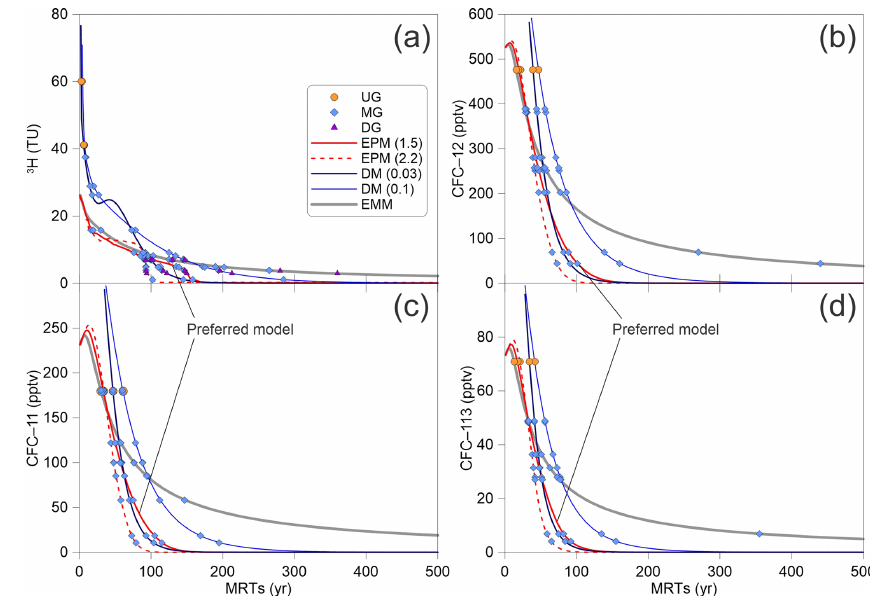
Figure 10. Tritium and CFCs (CFC-11, CFC-12, and CFC-113) output vs. mean residence times for different lumped parameter models estimated using Eqs. (2) to (5). The input 3 H activity and CFCs concentration are using the estimated 3 H activity in precipitation in Urumqi station (Fig. 4) and the Northern Hemisphere atmospheric mixing ratio (Fig. 3), respectively.